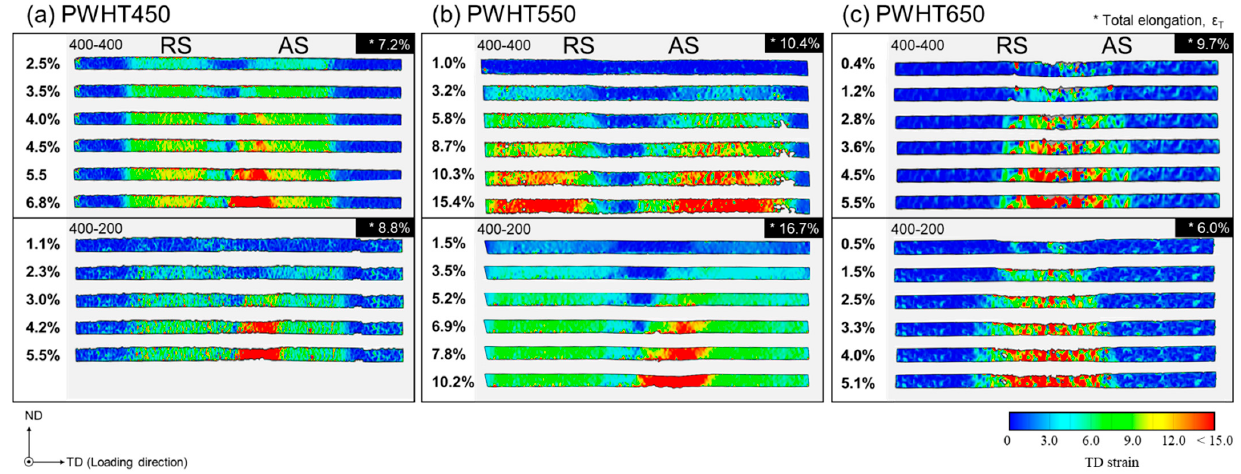
Figure 8. Cross-sectional contour maps of the strain distribution during the tensile test with the DIC: the FSW400-400 and 400-200 samples which were subjected to subsequent annealing at different temperatures of ( a ) 450 °C, ( b ) 550 °C, and ( c ) 650 °C for 1 h.